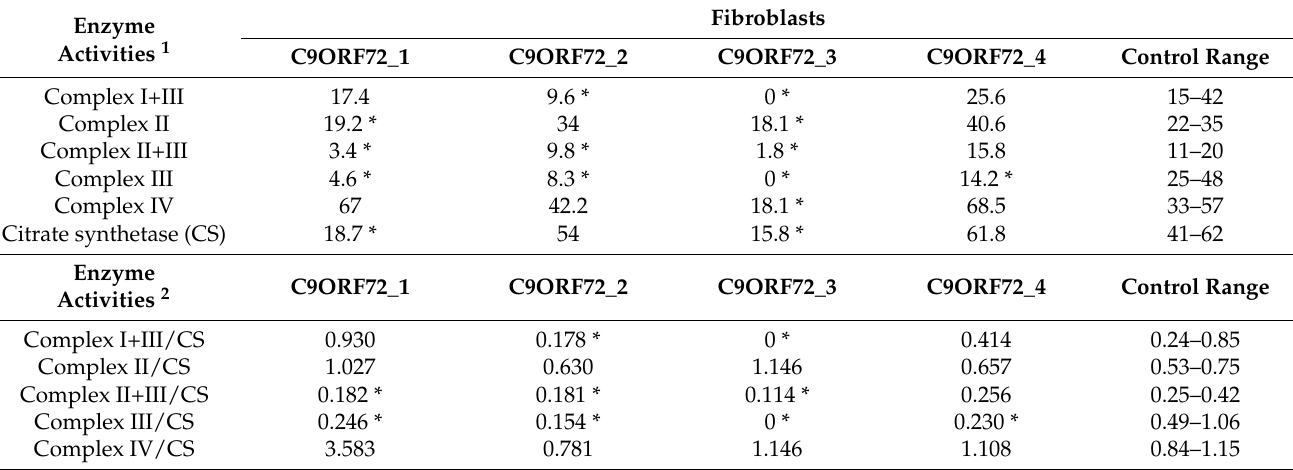
Table 2. Enzymatic activities of the mitochondrial respiratory chain in the fibroblasts from C9ALS/FTD patients.